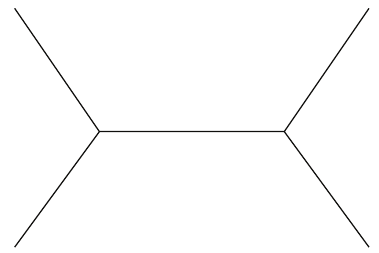
Figure 1: An example of Feynman